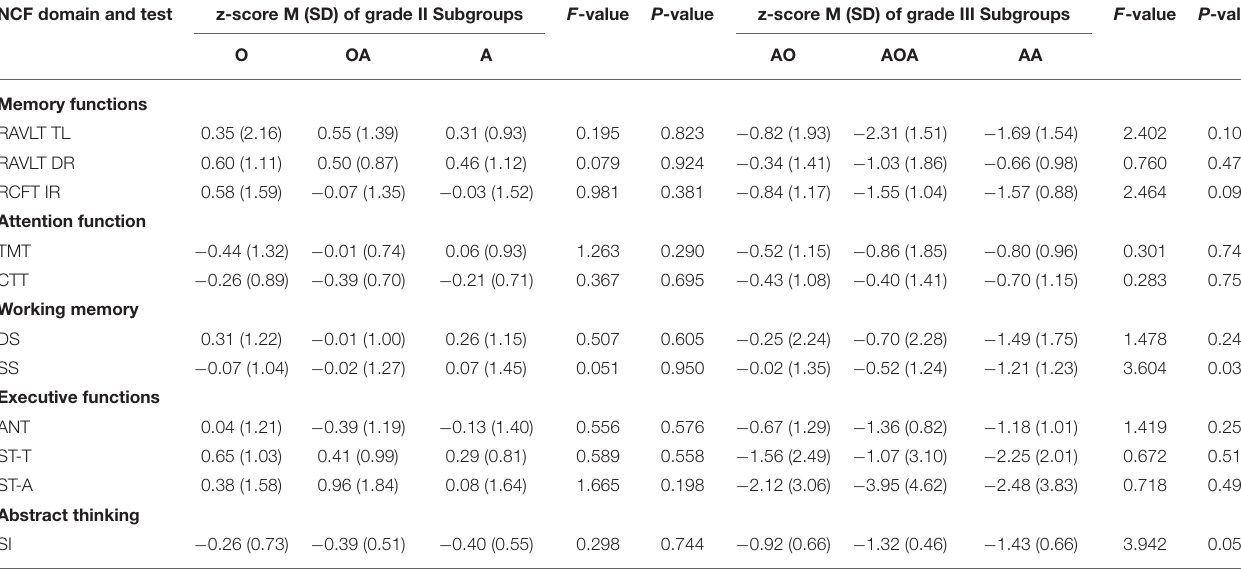
TABLE 6 | Differences of neurocognitive performances (z-scores) in subgroups based on morphology. NCF domain and